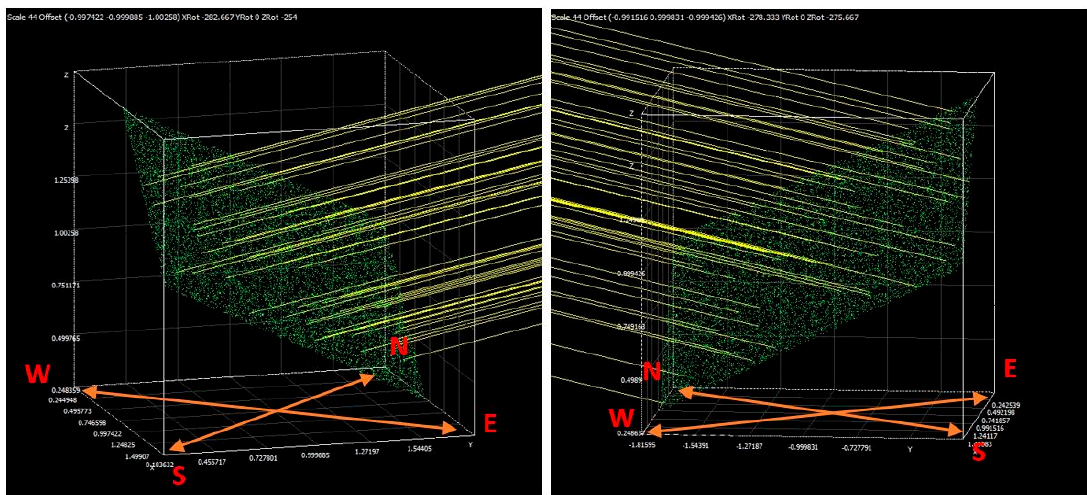
Figure 11. Incident solar radiation on the panel—east and west.